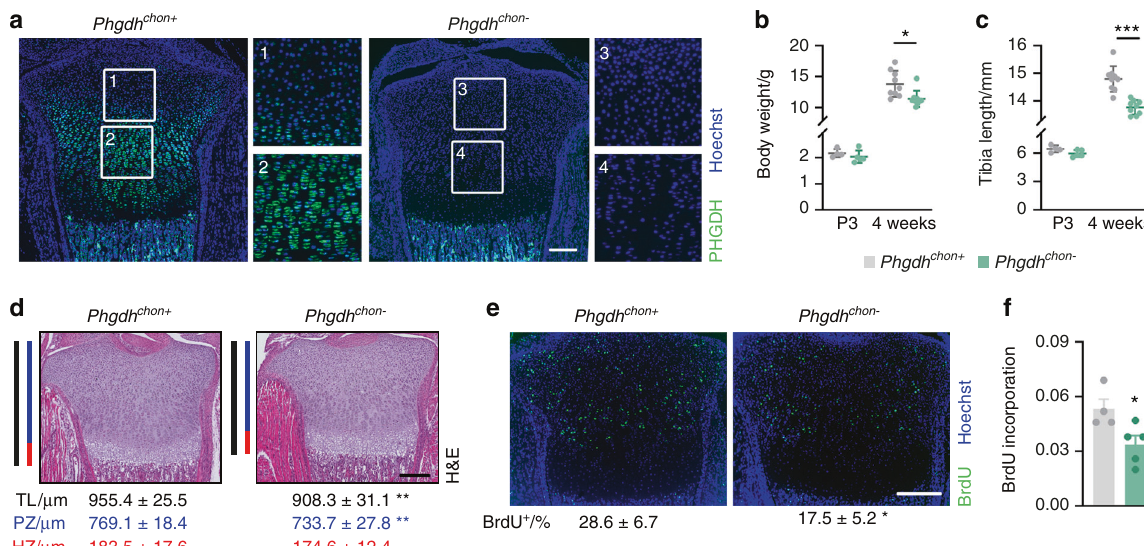
Fig. 2 PHGDH in chondrocytes controls bone growth. a PHGDH immunostaining in neonatal growth plates from wild-type ( Phgdh chon + ) and chondrocyte-speci fi c PHGDH knockout ( Phgdh chon- ) mice ( n = 4 – 5). Enlarged images are shown for the boxed regions. Body weights ( b ) and tibia lengths ( c ) of mice at postnatal day 3 (P3) and at 4 weeks of age ( n = 4 – 9). d H&E staining of the tibial growth plate at P3, with quanti fi cation of the total length (TL; black line) and the lengths of the proliferative zone (PZ; blue line) and hypertrophic zone (HZ; red line) ( n = 4-5). e BrdU immunostaining in neonatal growth plates, with quanti fi cation of the percentage of BrdU-positive cells ( n = 4-5). f Proliferation of cultured chondrocytes ( n = 4 – 5), as determined by BrdU incorporation. The data are presented as the means ± SDs; * P < 0.05 vs. Phgdh chon + , ** P < 0.01 vs. Phgdh chon + , *** P < 0.001 vs. Phgdh chon + (Student ’ s t test). The scale bars in a , d , e represent 200